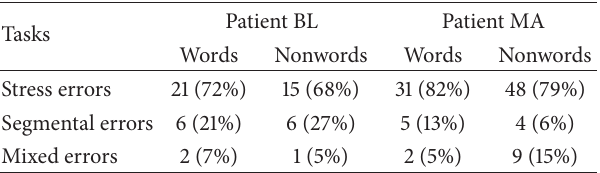
Table 4: Type of errors produced by patients BL and MA in reading words and